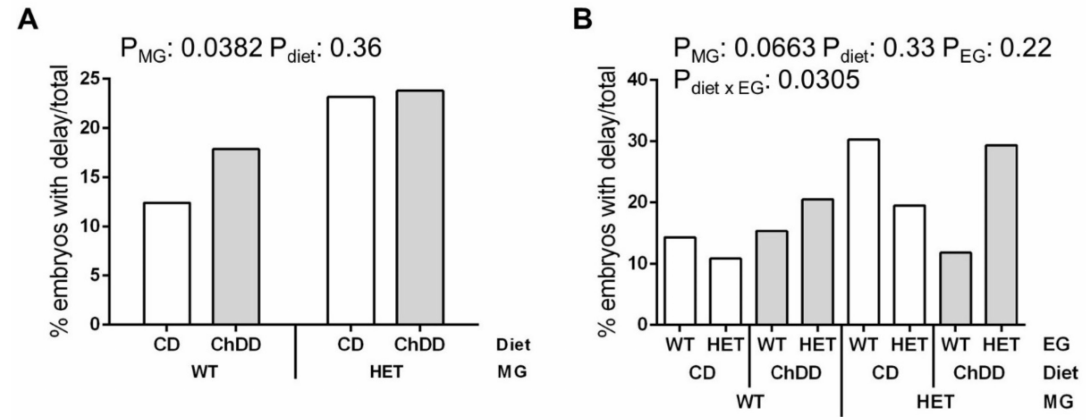
Figure 1. Effect of synthetase deficiency and low choline diet on incidence of developmental delay at E10.5. Values are % embryos with delay/total embryos evaluated. n = 33–78 embryos from 16–18 litters per group, analysed by binary logistic regression including litter as a random effect, mvt post-hoc. ( A ) Maternal effects, with embryo genotypes grouped. ( B ) Genotype and diet effects, including embryonic genotype. White bars: control diet (CD), grey bars: choline-deficient diet (ChDD). WT: wild type ( Mthfd1S +/+ ); HET: heterozygous ( Mthfd1S +/ − ); MG: maternal genotype; EG: embryonic